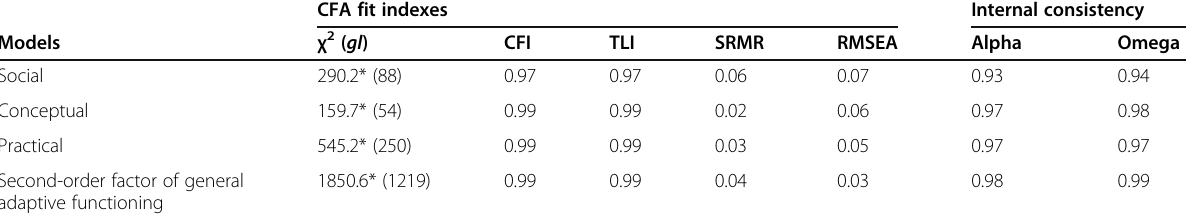
Table 2 Confirmatory factor analysis fit indexes and internal consistency of EFA-DI ’ s domains and general